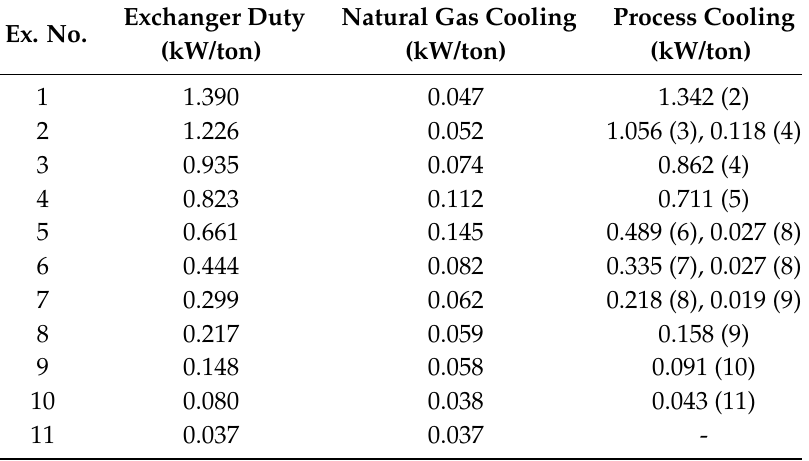
Table 3. Heat exchanger power (kW/ton NG). Numbers in parentheses indicate the circuit number. Ex. No.